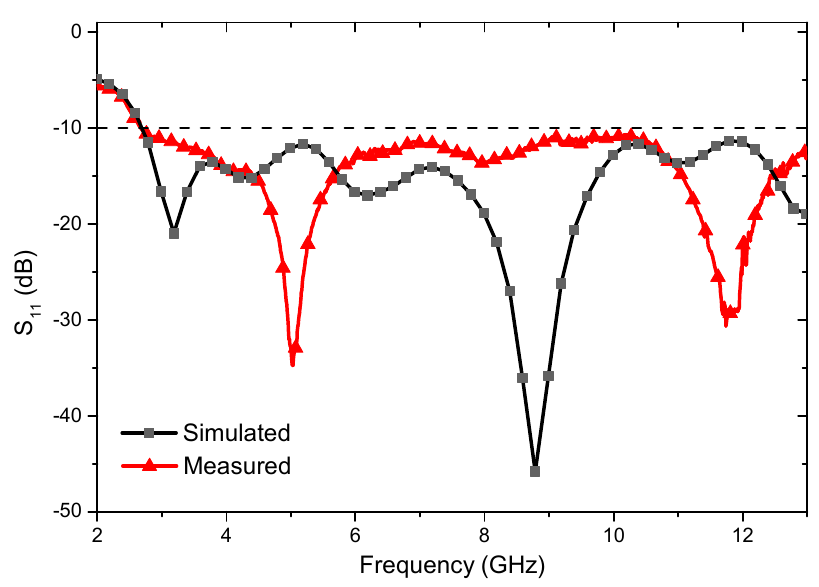
Figure 3. Simulated and measured return loss graphs of the proposed antenna.